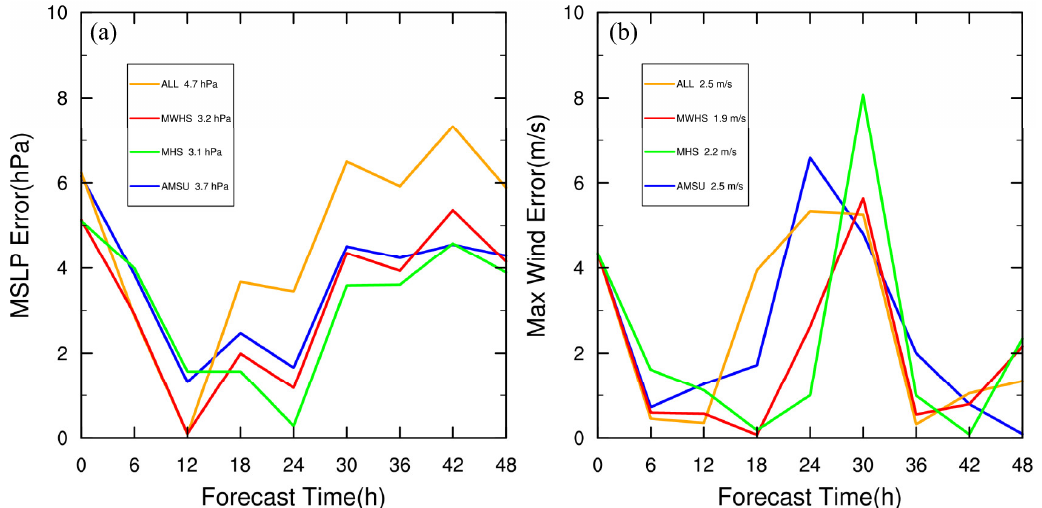
Figure 14. ( a ) The MSLP error (hPa) and ( b ) MSW error (m/s) in the 48-h intensity forecast initialized at 1800UTC on 21 July 2018.